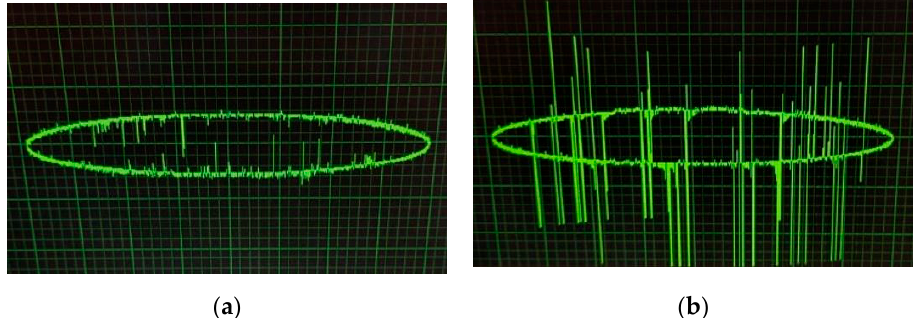
Figure 11. Waveforms of PD pulses at 5.5 kV applied voltage: ( a ) Paper impregnated to sNF; ( b ) Paper